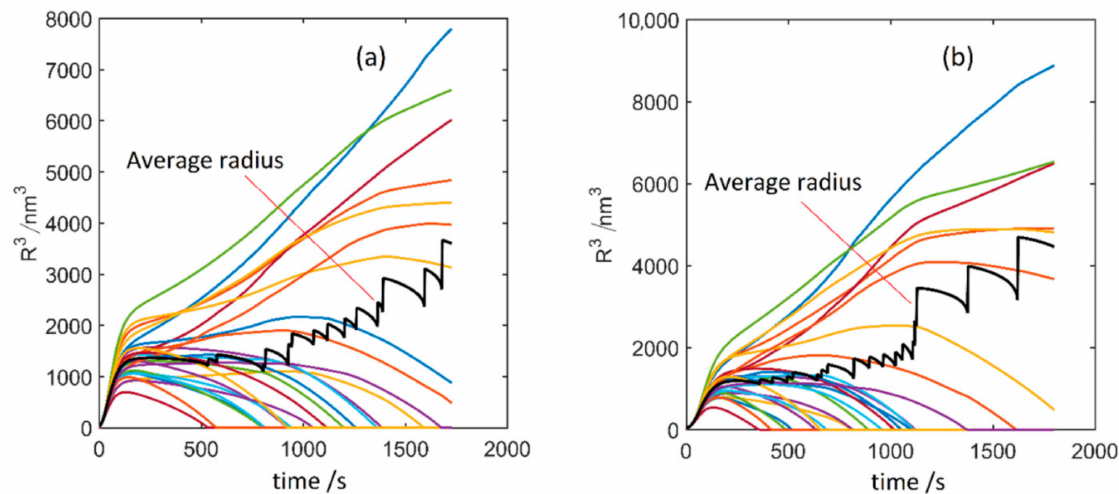
Figure 10. Evolution of θ (cid:48) precipitates; ( a ) without; and ( b ) with the chemo-mechanical coupling effect. In contrast to the spherical δ (cid:48) precipitates in Al-Li (Figure 3 in Ref. [10]), the coupling has almost no effect on the θ (cid:48) ripening. The colored lines associate with the individual θ (cid:48) precipitates in the simulation box.